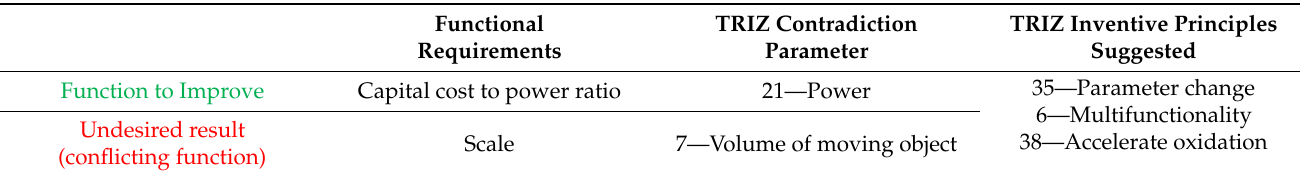
Table 8. Example of suggested inventive principles for the conflicting requirements in the novel wave energy case, showing both the function to be improved (highlighted in green) and the undesired conflicting result (Highlighted in red) for the highest conflicting functional requirements, plus the TRIZ inventive principles that may help resolve